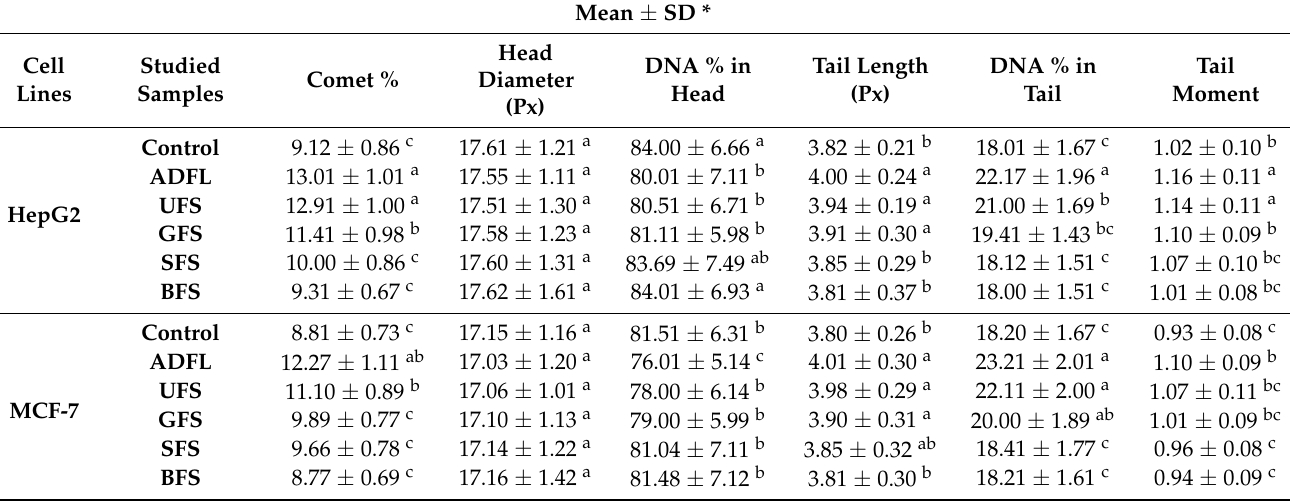
Table 5. DNA damage using Comet assay for the HepG2 and MCF-7 cell lines treated with the IC 5o ( µ g mL − 1 ) doses of control: untreated cell line, and crude extracts of ADFL: air-dried fenugreek leaves, UFS: unprocessed fenugreek seeds, GFS: germinated fenugreek seeds, SFS: soaked fenugreek seeds, and BFS: boiled fenugreek